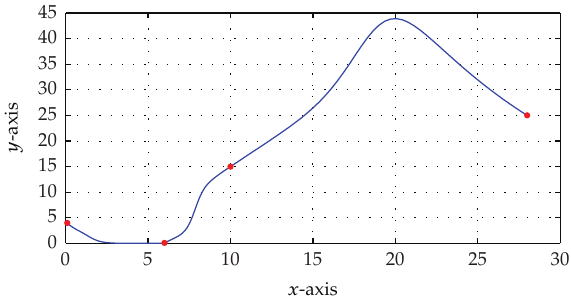
Figure 4: C 1 rational trigonometric cubic function with α i (cid:8) 0 . 5 , δ i (cid:8) 1 .